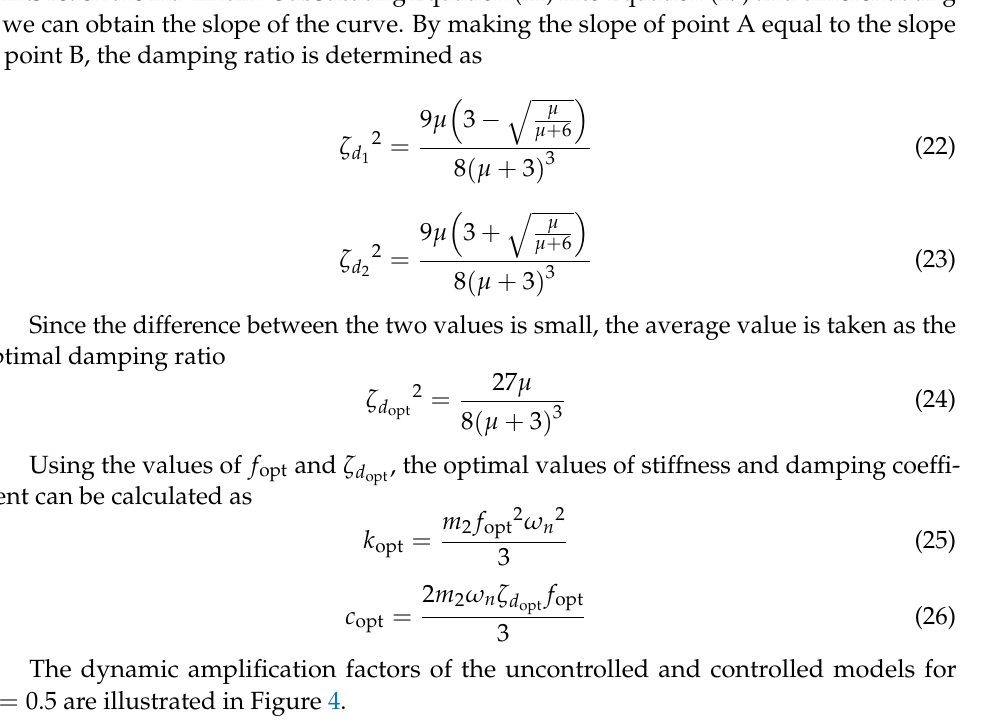
The optimal value of ζ d should make the dynamic amplification factor of the two fixed points reach the maximum. Substituting Equation (21) into Equation (19) and differentiating g , we can obtain the slope of the curve. By making the slope of point A equal to the slope of point B, the damping ratio is determined as